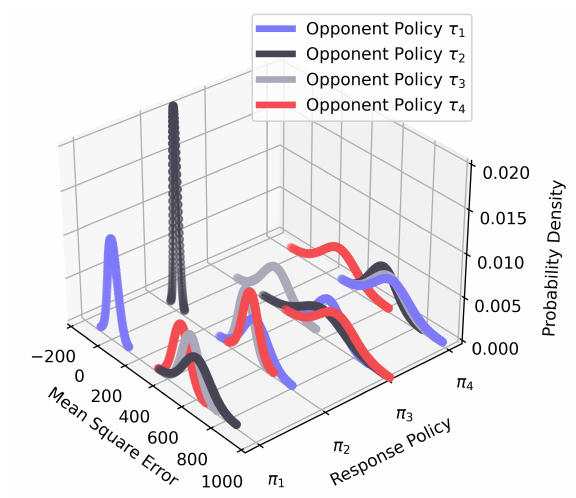
Figure 7. The planning similarity model Θ